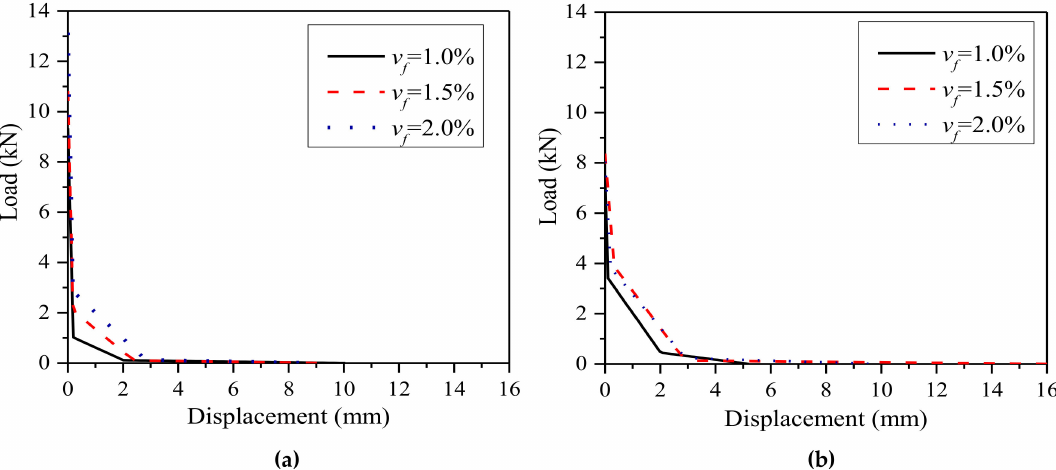
Figure 13. Trilinear strain-softening diagrams of steel fiber-reinforced SGM/SGC. ( a ) SGM; ( b )